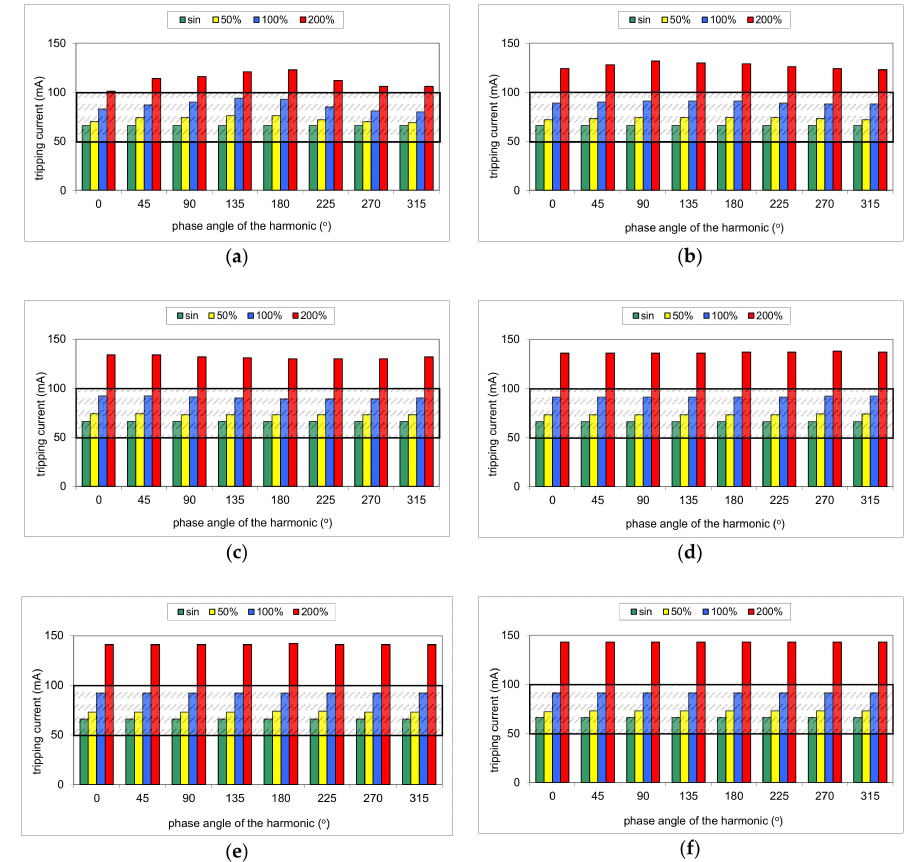
Figure 11. Tripping current of the A-type 100 mA RCD (no. RCD100) for testing waveform comprising the fundamental and the following high-frequency components: ( a ) 3 rd harmonic; ( b ) 5 th harmonic; ( c ) 7 th harmonic; ( d ) 11 th harmonic; ( e ) 23 rd harmonic; ( f ) 49 th harmonic. Tested percentages of harmonic-to-fundamental: 50%, 100%, and 200%, and phase angles of the harmonic: 0 ◦ , 45 ◦ , 90 ◦ , 135 ◦ , 180 ◦ , 225 ◦ , 270 ◦ , 315 ◦